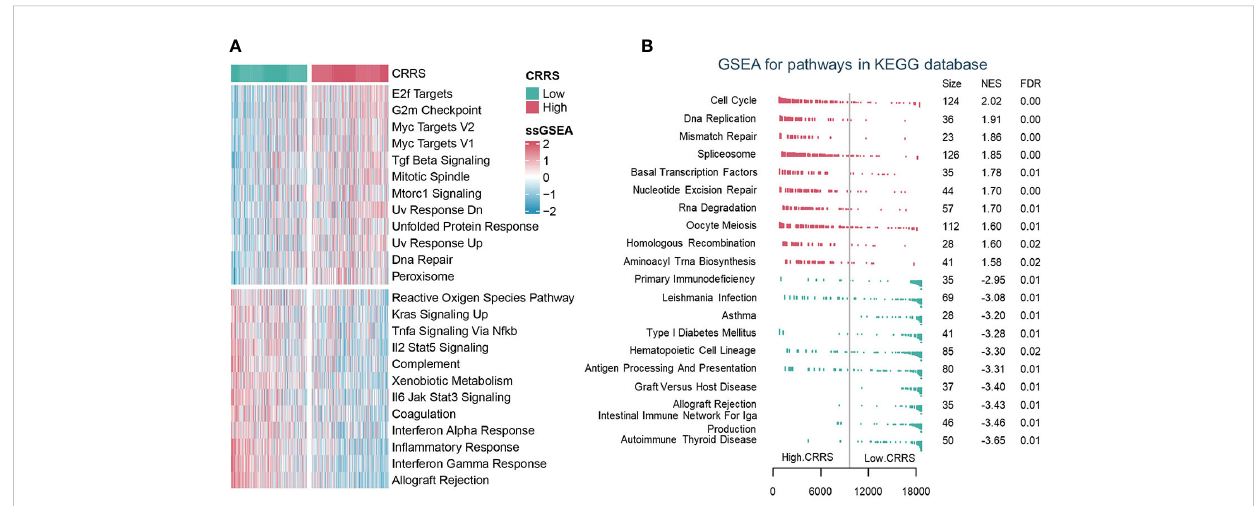
FIGURE 3 The biological characteristics of different risk groups. (A) . GSVA analysis of Hallmark gene sets in the low and high CRRS groups. (B) . GSEA analysis of KEGG pathway gene sets in groups with low and high